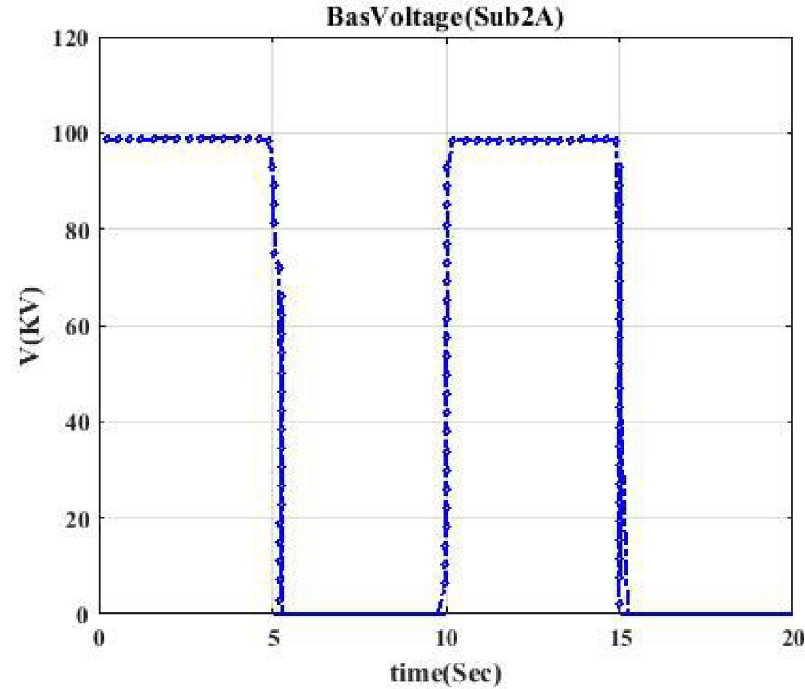
Fig 3. Voltage profile related to switching Sub2A-CB1. This shows the voltage curve when circuit breaker CB1 is switched.